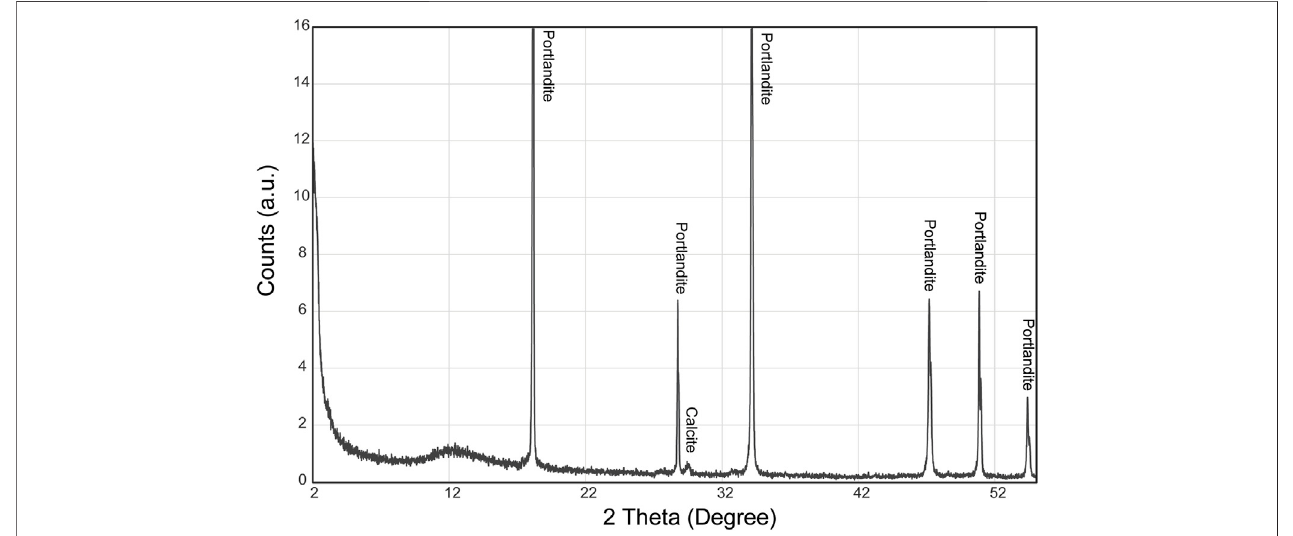
FIGURE10| XRDpatternoftheprecipitate.Portlanditeisidenti fi edasamajorphasepresentintheprecipitateandonlyasmallpeakfromcalciteispresentat29.5 ° .